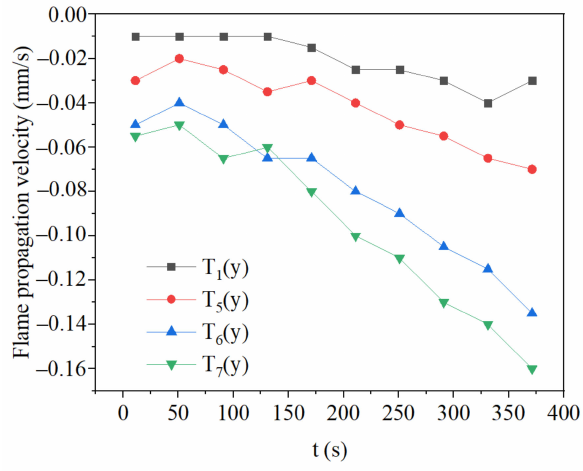
Figure 28. Variation of flame propagation velocity with time at different widths of high-temperature zone with the inlet flow rate of 700 m 3 /h, X CH